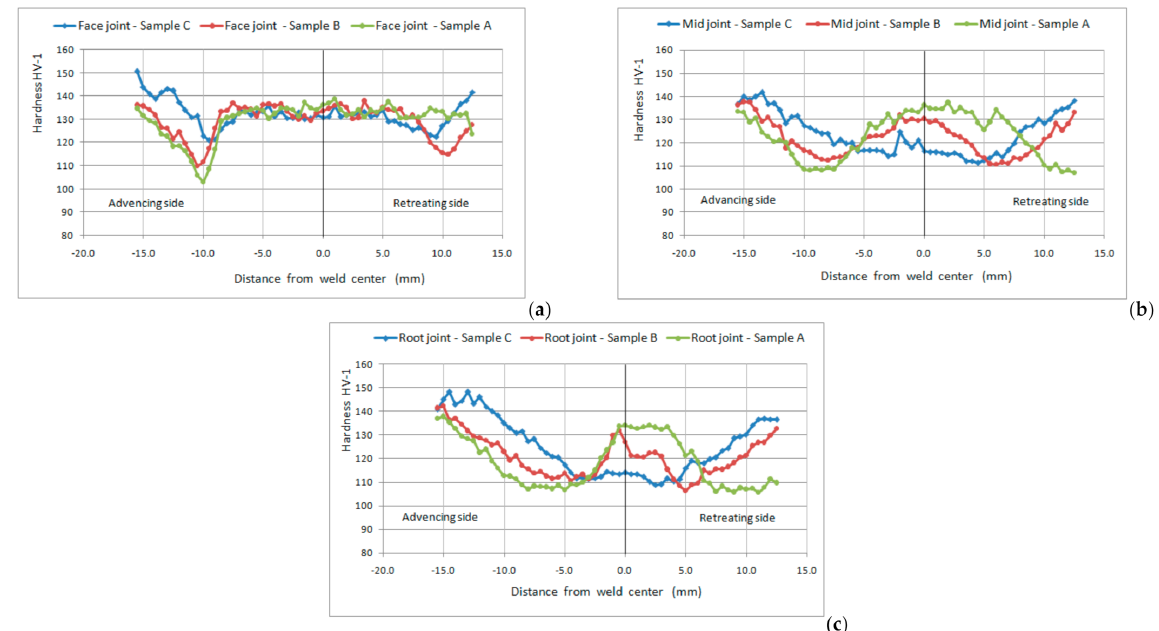
Figure 7. Hardness profile of the welded joint for different welding parameters obtained by measuring at ( a ) a distance of 1 mm from the face of the welded joint; ( b ) a distance of 3 mm from the face of the welded joint; ( c ) a distance of 5 mm from the face of the welded